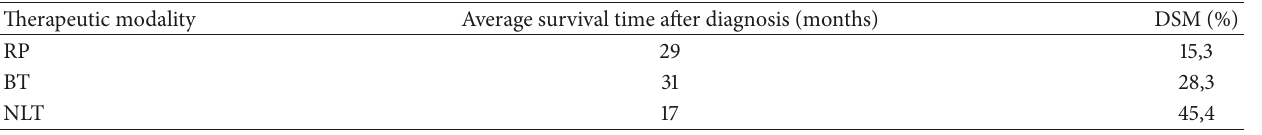
Table 2: Overall survival and cancer-specific survival by therapeutic modality, adapted from Culp et al. (2014) [13]. Therapeutic modality 5-year OS rate (%) 5-year CSS rate (%) RP 67,4 75,8 52,6 61,3 22,5 48,7